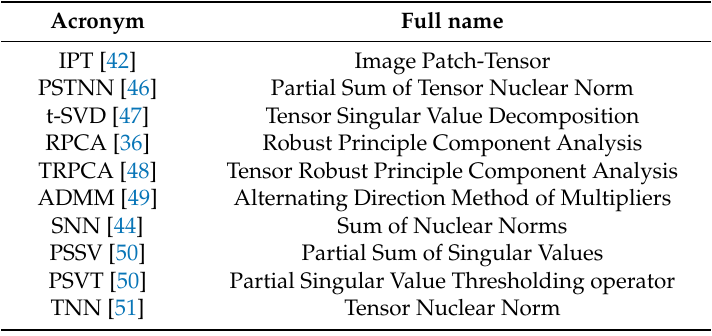
Table 2. Detailed parameter settings of the 10 tested